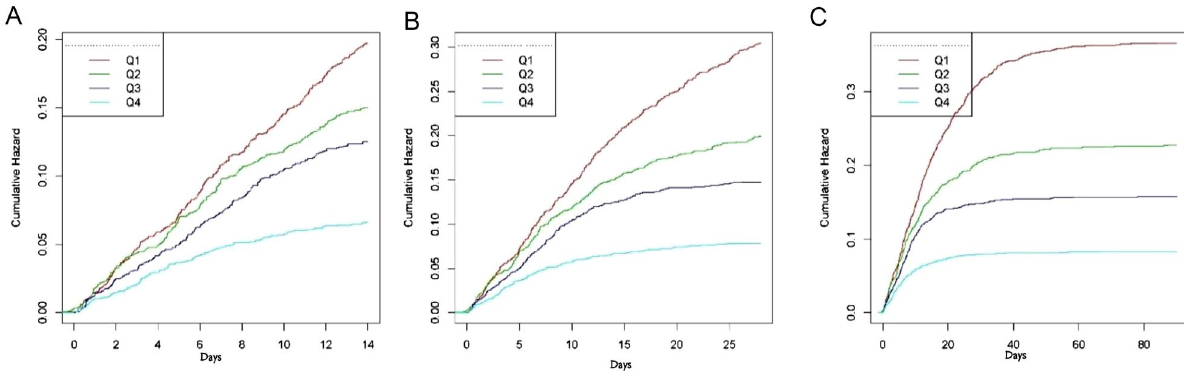
Figure 2. Kaplan–Meier chart of probability of cumulative hazard among the different average albumin levels. ( A ) Kaplan–Meier chart of probability of 14th day survival among the different albumin levels. ( B ) Kaplan– Meier chart of probability of 28th day survival among the different albumin levels. ( A ) Kaplan–Meier chart of probability of 90th day survival among the different albumin levels.